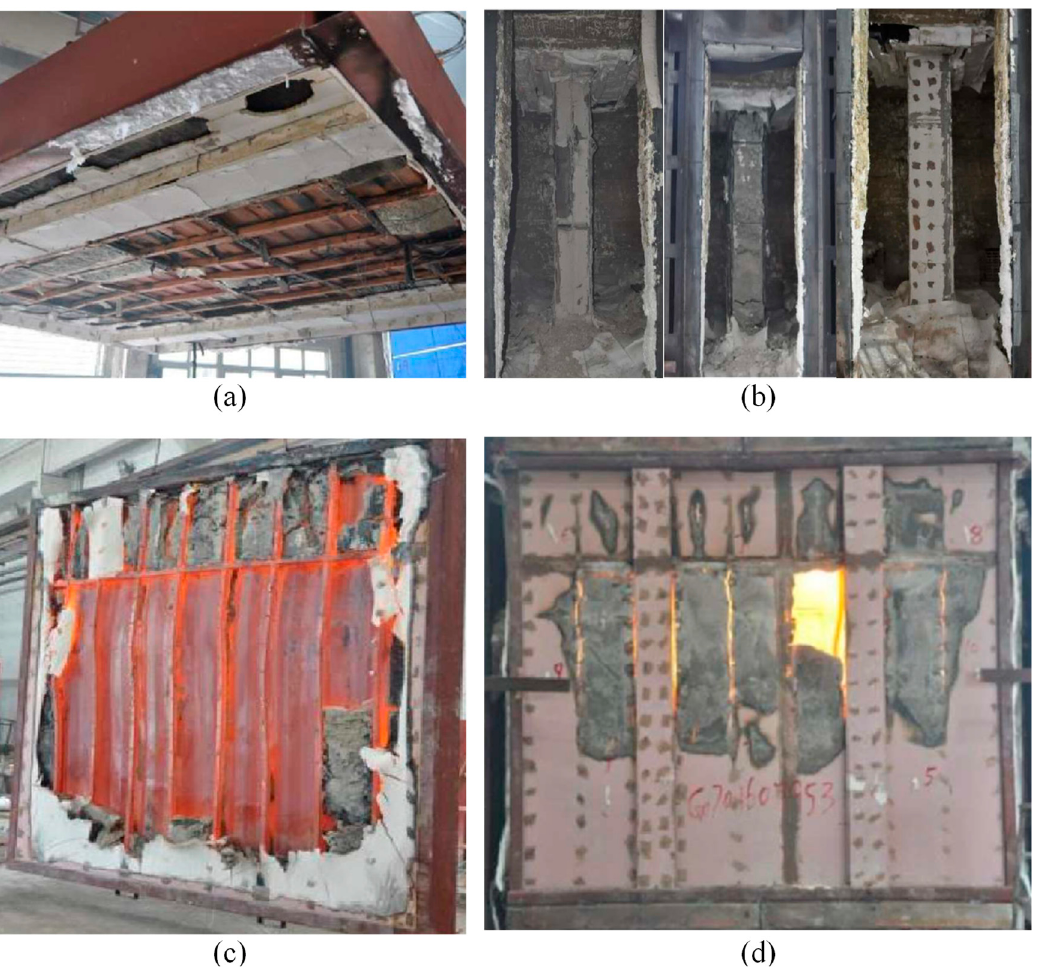
Figure 11. Fire performance of IMU in PFISB [129]. ( a ) floor; ( b ) columns; ( c ) non-load-bearing wall; and ( d ) load-bearing